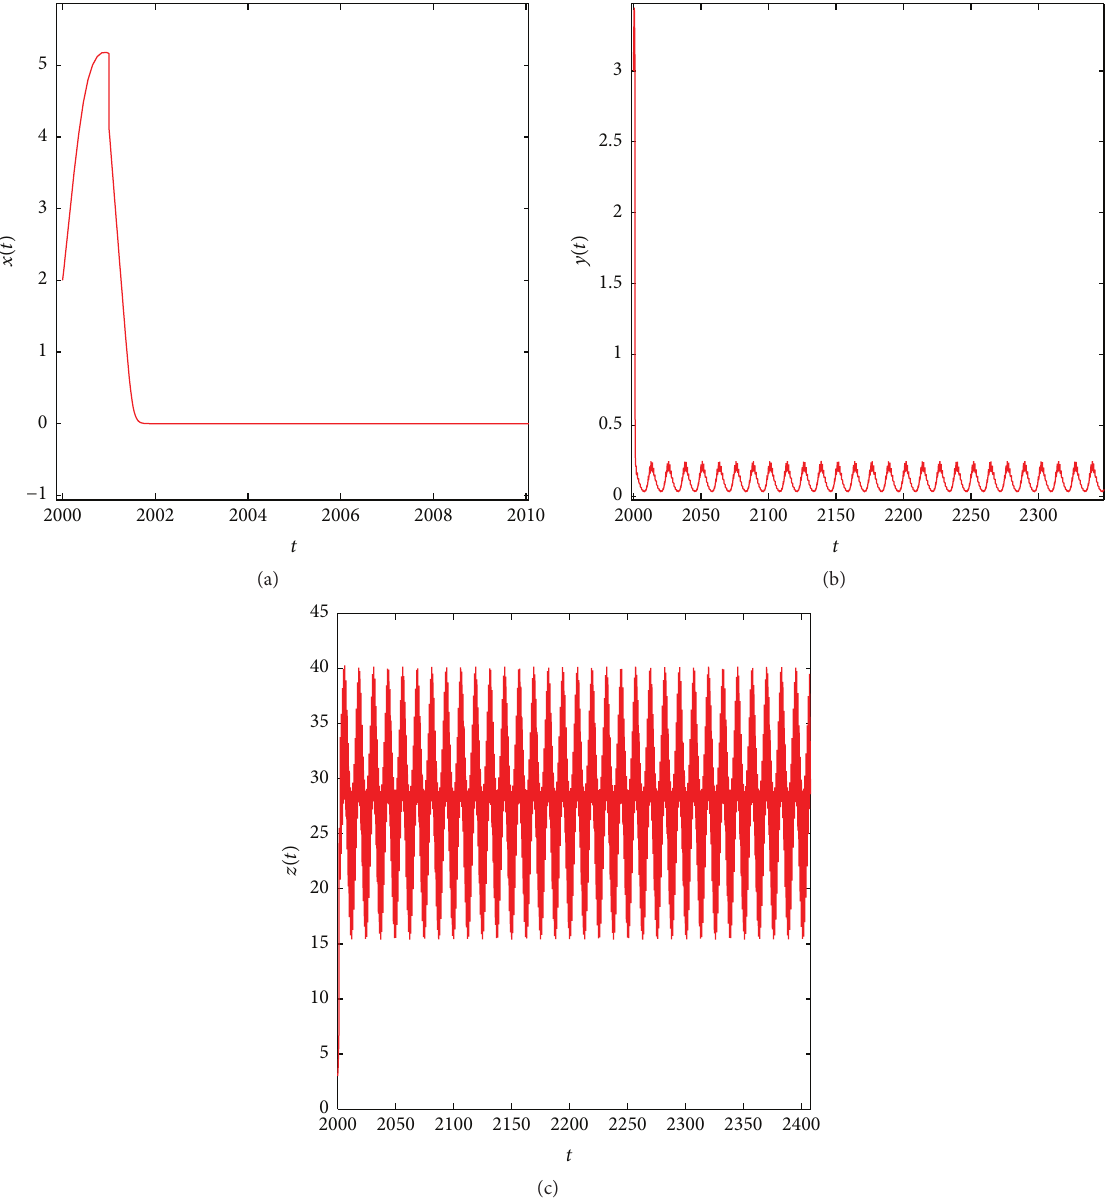
Figure 12: ((a) and (b)) Time series showing extinction of 𝑥(𝑡) population, time series showing increased biomass level of 𝑦(𝑡) population; (c) time series showing relatively low biomass level of 𝑧(𝑡) population of system (2) with mixed Holling type II-III functional responses ( 𝑝 = 1 , 𝑞 = 1 , 𝑠 = 2 , and 𝑟 = 2 ) in presence of seasonal perturbation with data set (45) and 𝑃 = 12 . long term dynamics for 𝜓 = 0 , 𝜋/2 , 𝜋 when 𝜔 varies from 0 to 0.4. If 𝜔 increases from 0 to 0.09, the system has rich changes in dynamics and shows periodic windows, period- doubling, chaos, and a chaotic crisis (see Figure 4(a)). Figures 4(b) and 4(c) show same pattern when 0 < 𝜔 <